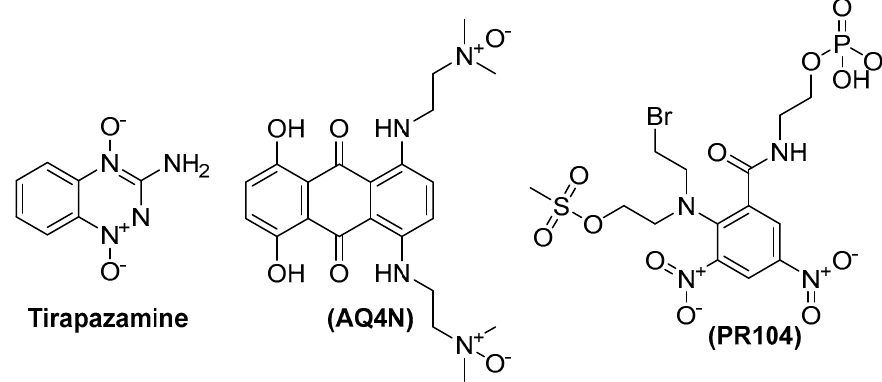
Figure 1. Hypoxia activated Prodrugs.